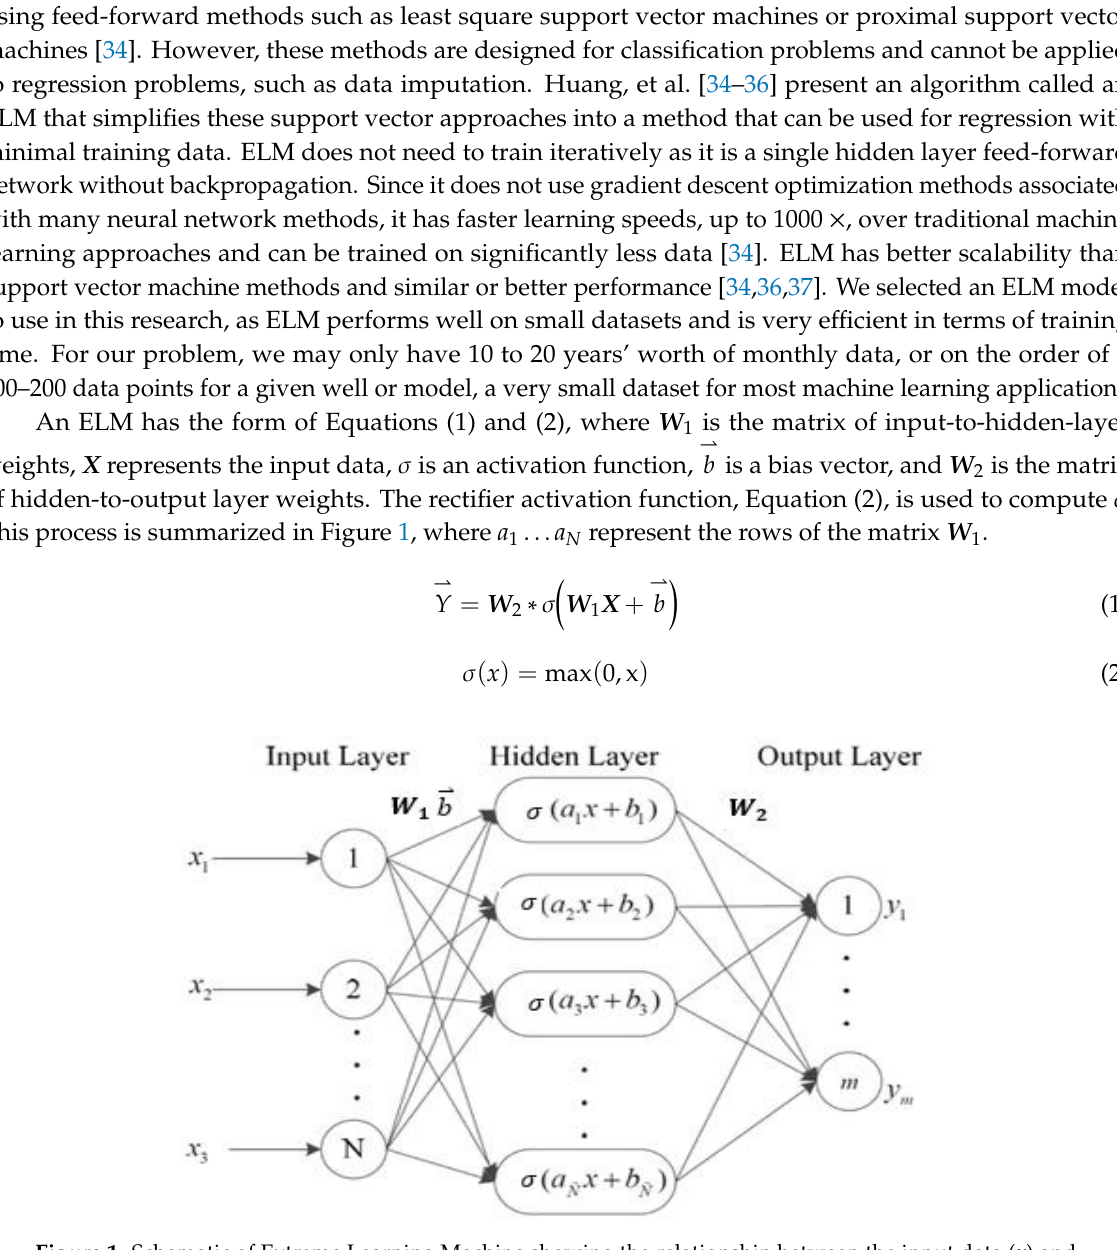
Figure 1. Schematic of Extreme Learning Machine showing the relationship between the input data ( x ) and the output data ( y ). This is a feed-forward network, without backpropagation, giving very fast training times and requiring less data for accurate computations.